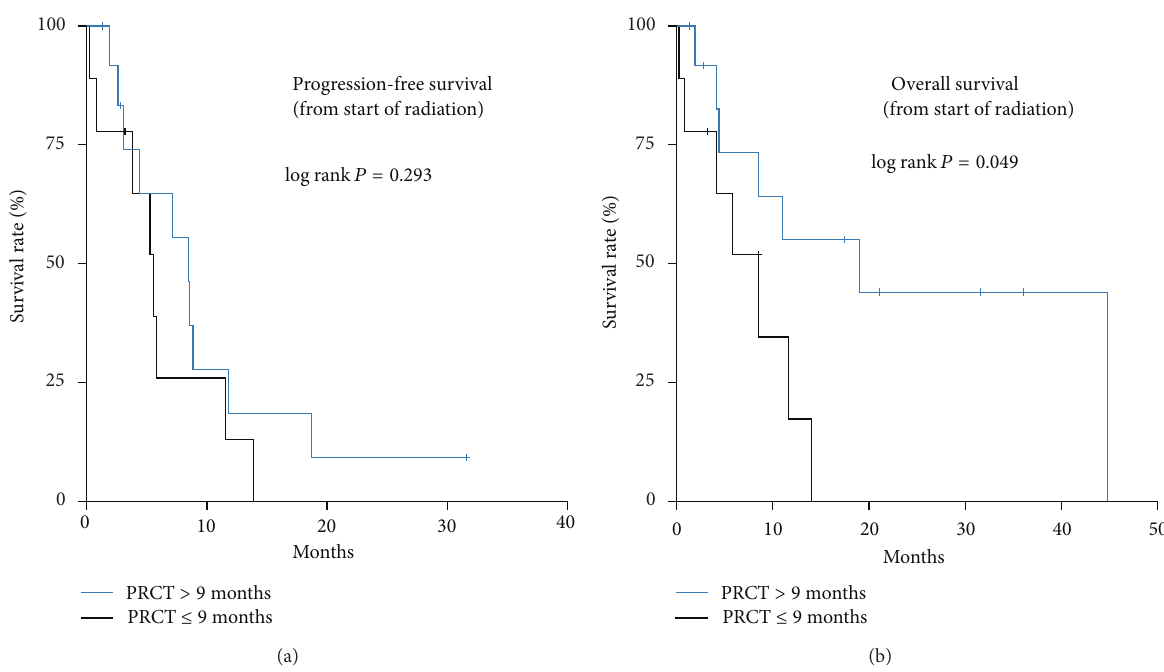
Figure 4: PFS and OS calculated from the he start of RT: duration of preradiation chemotherapy > 9 months versus ≤ 9 months.